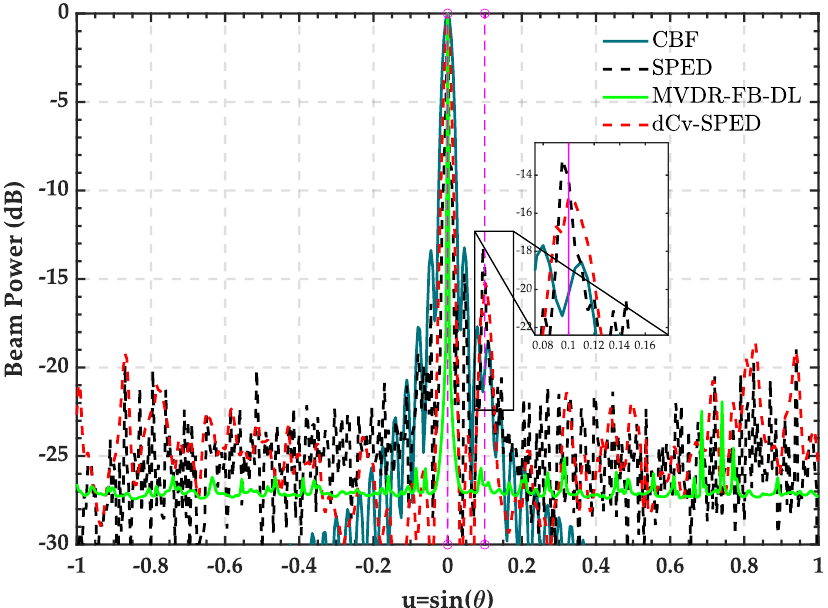
Figure 5. Spatial spectra estimated by the CBF, SPED, MVDR-FB-FL, and dCv-SPED when the noise was 10 dB.